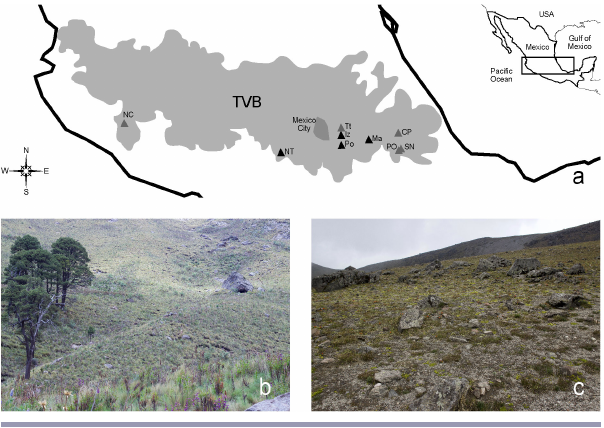
Fig. 1 . Map of study sites and images of alpine habitats indicating: (a) four volcanoes of the Trans-Mexican Volcanic Belt (TVB) including Nevado de Toluca (NT),